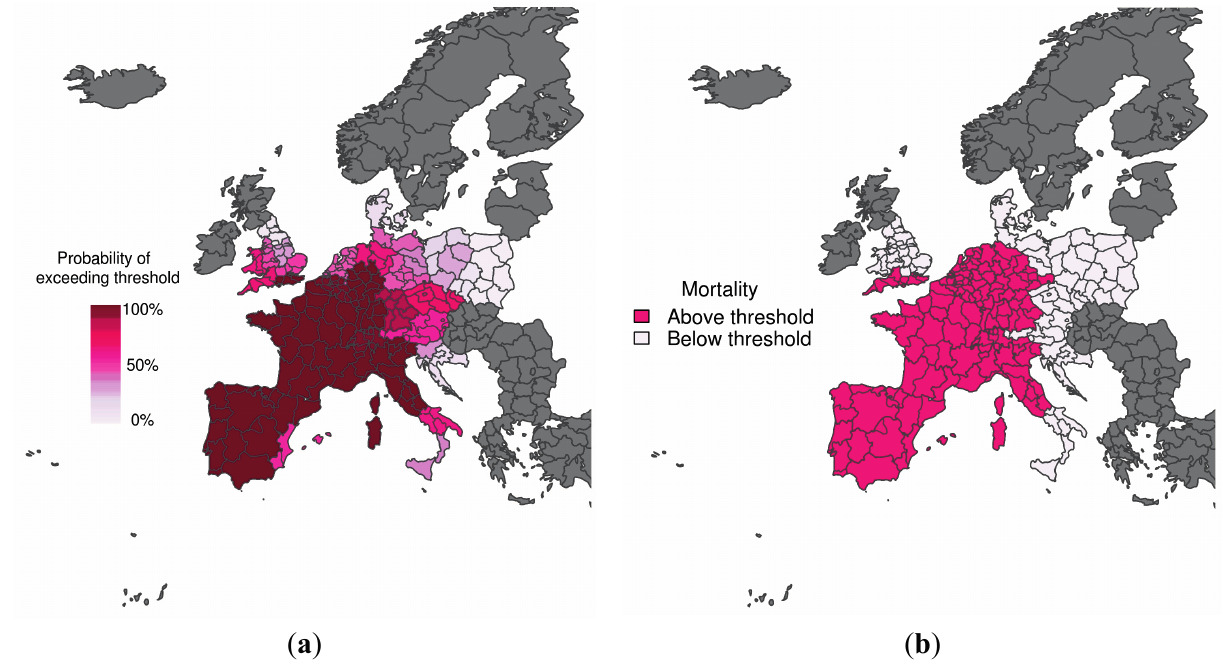
Figure 2. ( a ) Probabilistic map of exceeding emergency daily mortality thresholds (75th percentile of daily mortality distribution in the warm tail); ( b ) Corresponding observations during a heat wave scenario (1–15 August 2003). The graduated colour bar represents the probability of exceeding the mortality threshold (ranging from 0%, pale colours, to 100%, deep